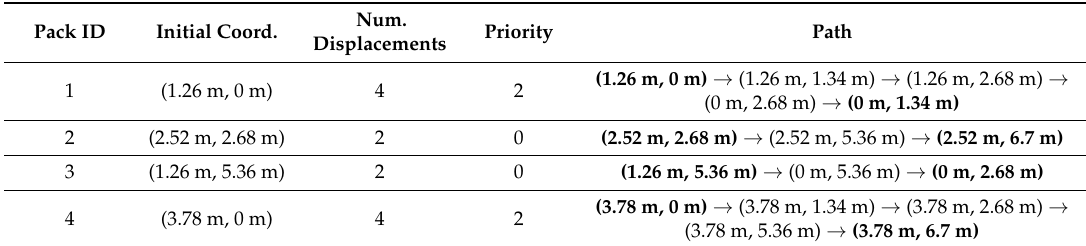
Table 3. Pallets Management by Implemented QCL